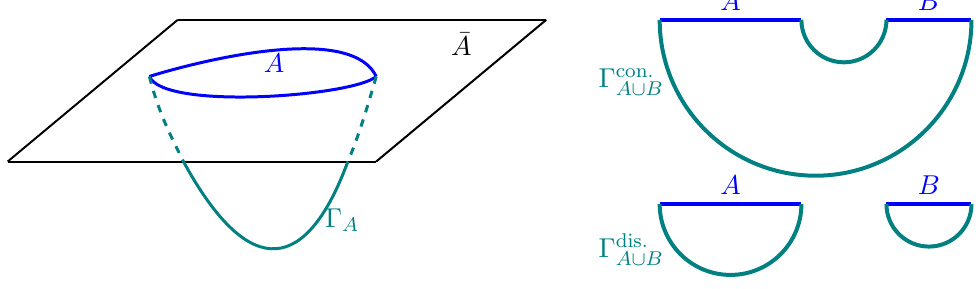
Figure 1 . Schematic con(cid:12)gurations for computing S latter case we have two di(cid:11)erent extremal con(cid:12)gurations denoted by (cid:0) con. to connected and disconnected RT surfaces